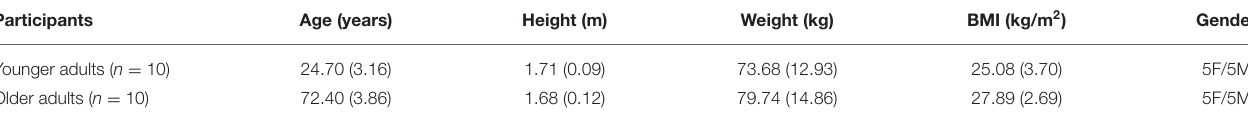
TABLE 1 | Participant demographics. Participants